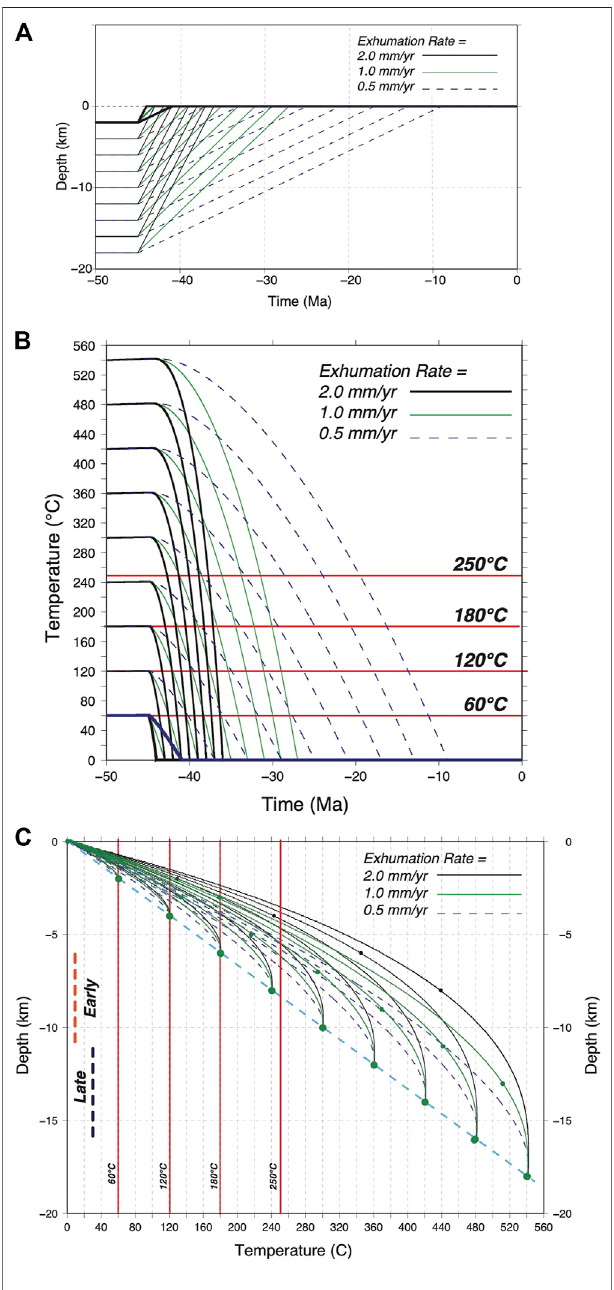
FIGURE 3 | Results of simple numerical exhumation models on thermal structure and history. (A) Simple exhumation histories used in the models. Three rates of exhumation are explored [0.5, 1.0, and 2.0 mm/yr (km/Ma)]. Horizons at 2 km depth intervals from 2 to 18 km are monitored. (B) Temperature histories for the monitored units. Red lines labeled with temperatures indicate approximate closure T for speci fi c low-T thermochronologic systems [60 ° C — Apatite (U-Th)/He; 120 ° C Apatite Fission Track; 180 ° C, Zircon (U-Th)/He]; and 250 ° C, Zircon Fission Track). (C) Temperature — depth histories for monitored units. Dashed blue line indicates initial crustal geotherm (75 mW/m 2 ; k (cid:2) 2.5 W/m-K; dT/dz (cid:2) 30 ° C/km).